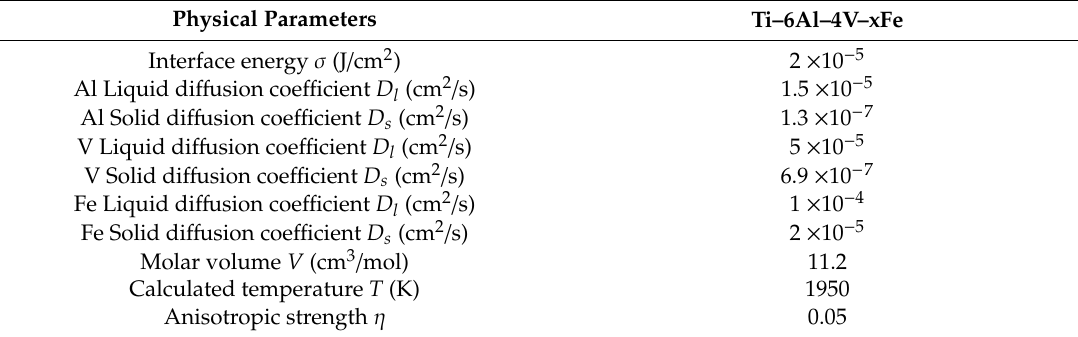
Table 1. Partial physical parameters [13,18,22].